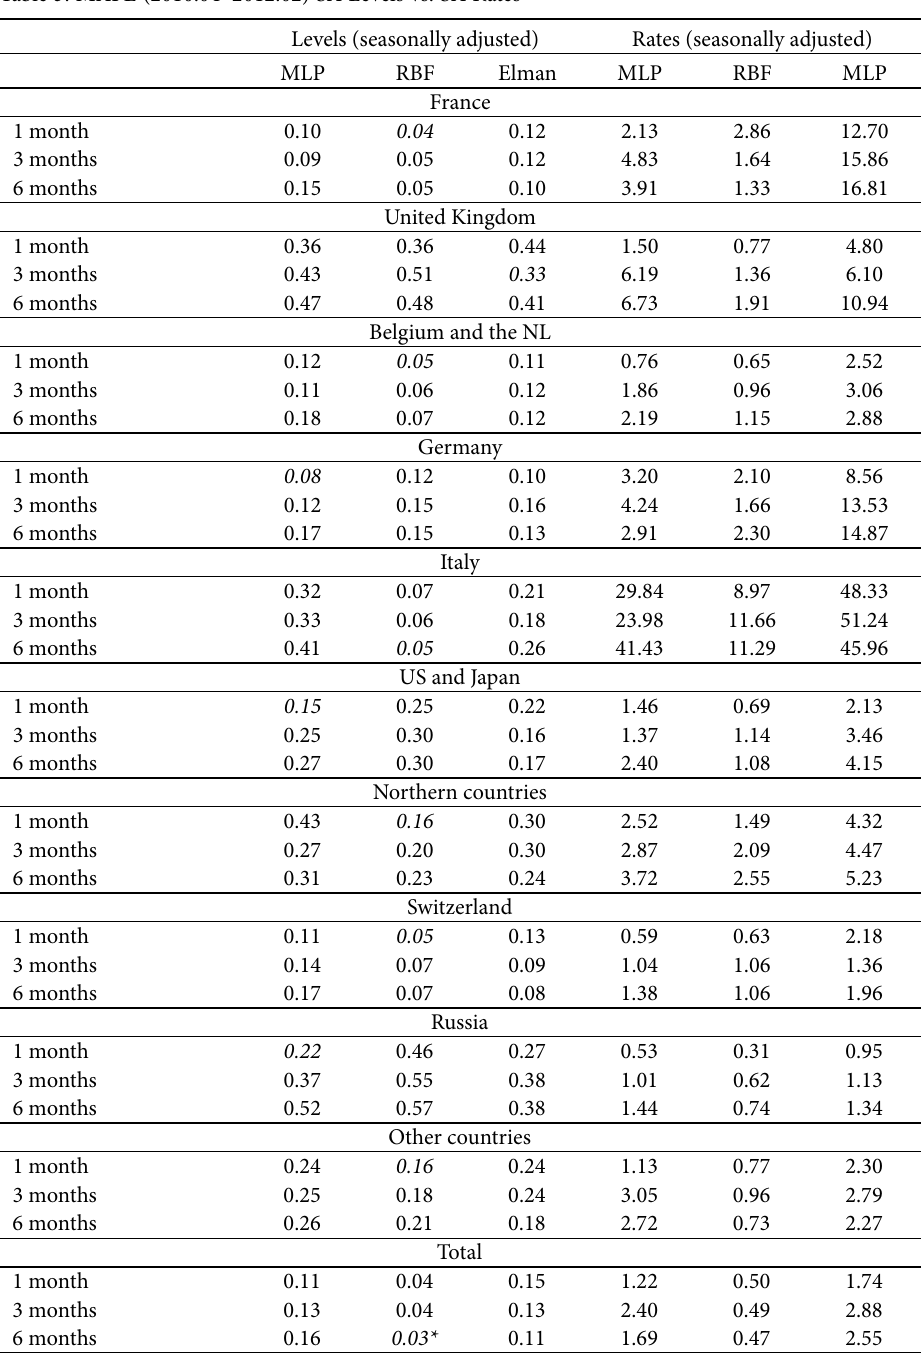
Table 5. MAPE (2010:04–2012:02) SA Levels vs. SA Rates Levels (seasonally